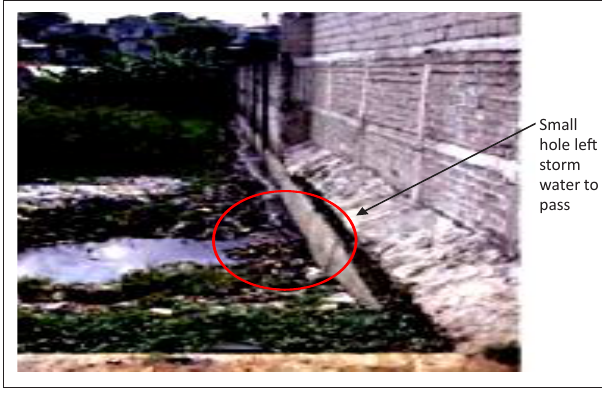
Source : Field work in Keko Machungwa, May 2009 FIGURE 4: Wall constructed by Oil Com Company blocking natural water flow.